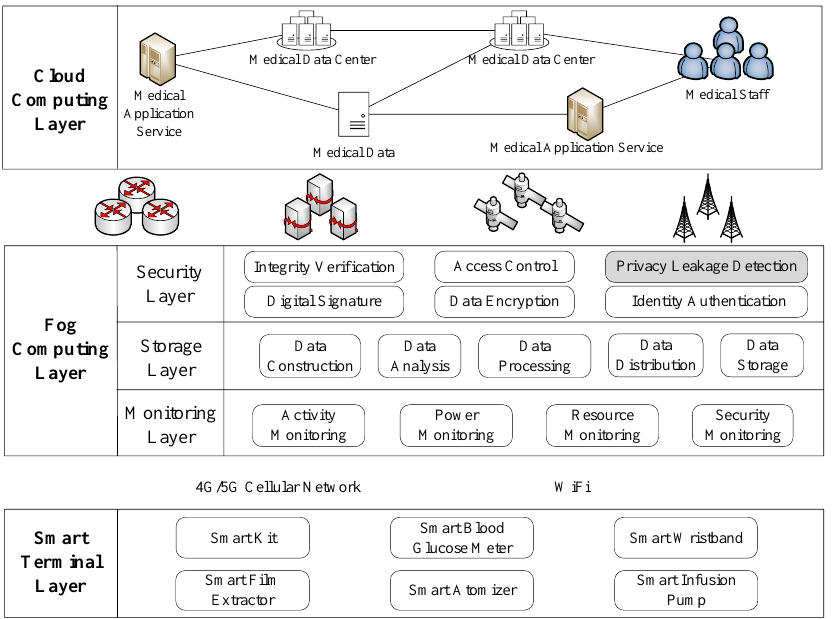
Figure 3. Logical architecture of fog computing for the healthcare